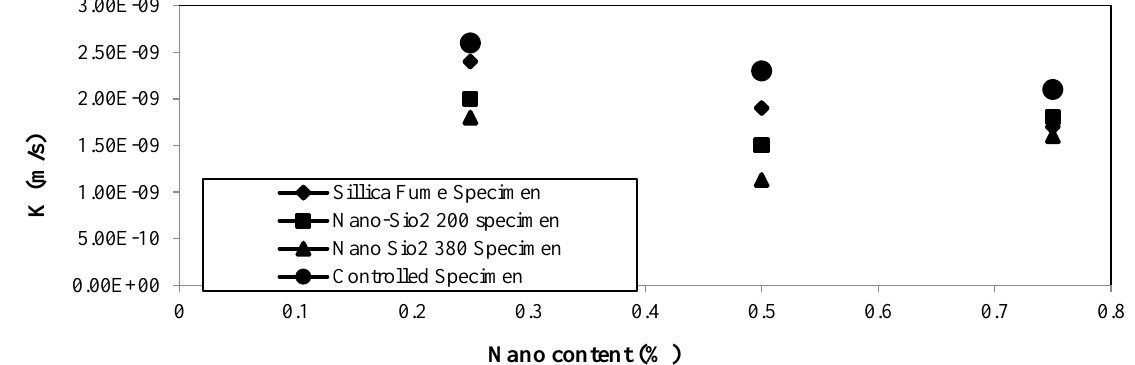
Fig. 13. Permeability of soil-cement mixtures with different silica